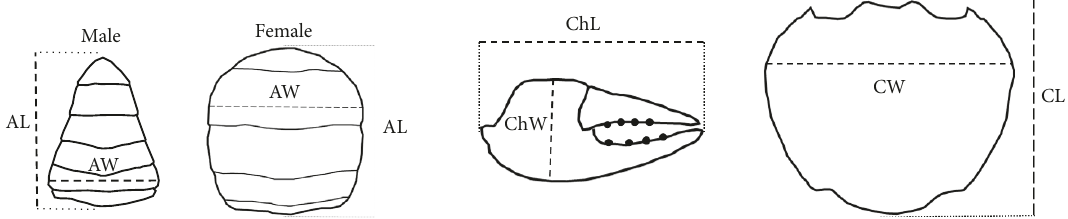
Figure 2: Position of measurements in Potamon algeriense . CW: carapace width; CL: carapace length; ChL: cheliped length; ChW: cheliped width; AW: abdomen width; AL: abdomen